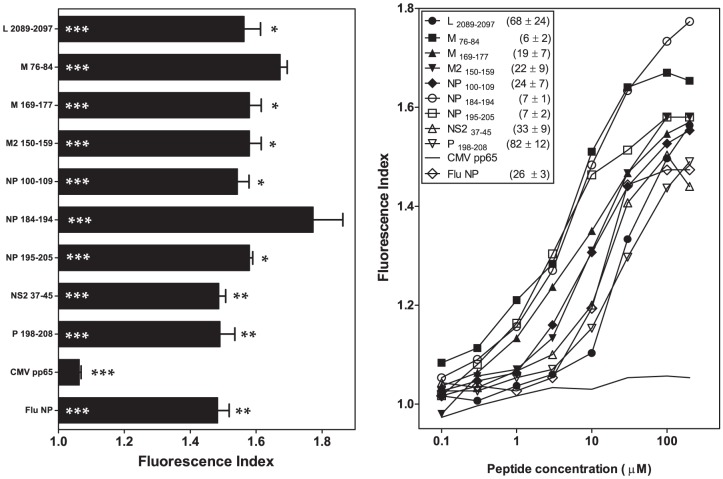
HLA-B*2709 stabilization with synthetic HRSV ligands.The stability of HLA-B*2709/peptide complexes on the cell surface of transfected RMA-S cells was measured through flow cytometry. The results shown in left and right panels are depicted as in Fig. 1A and 2B, respectively, showing the mean values obtained from three or four independent experiments.